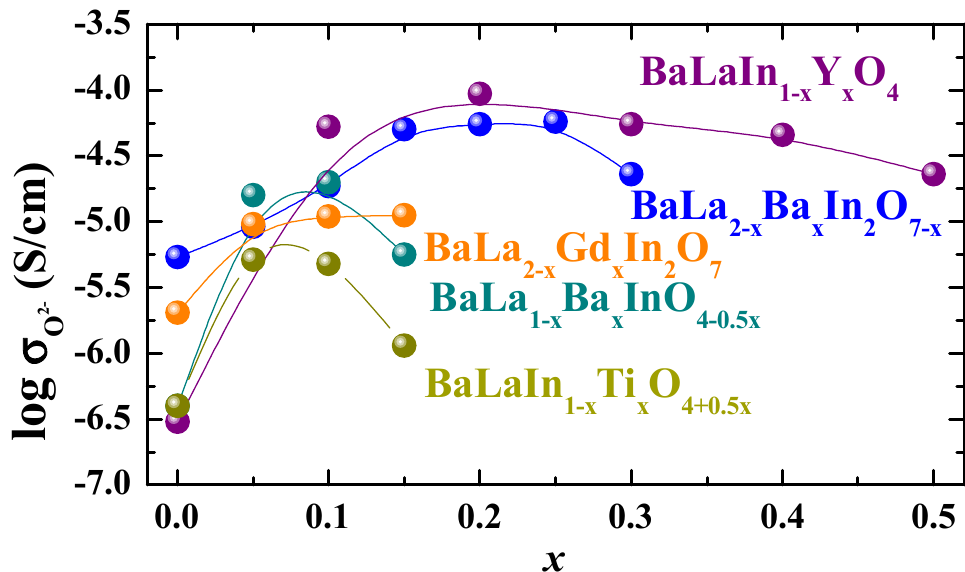
Figure 6. The concentration dependencies of oxygen-ionic conductivities for heterovalent-doped BaLa 1– x Ba x InO 4–0.5 x [76], BaLaIn 1– x Ti x O 4+0.5 x [78], BaLa 2– x Ba x In 2 O 7– x [89] and isovalent-doped